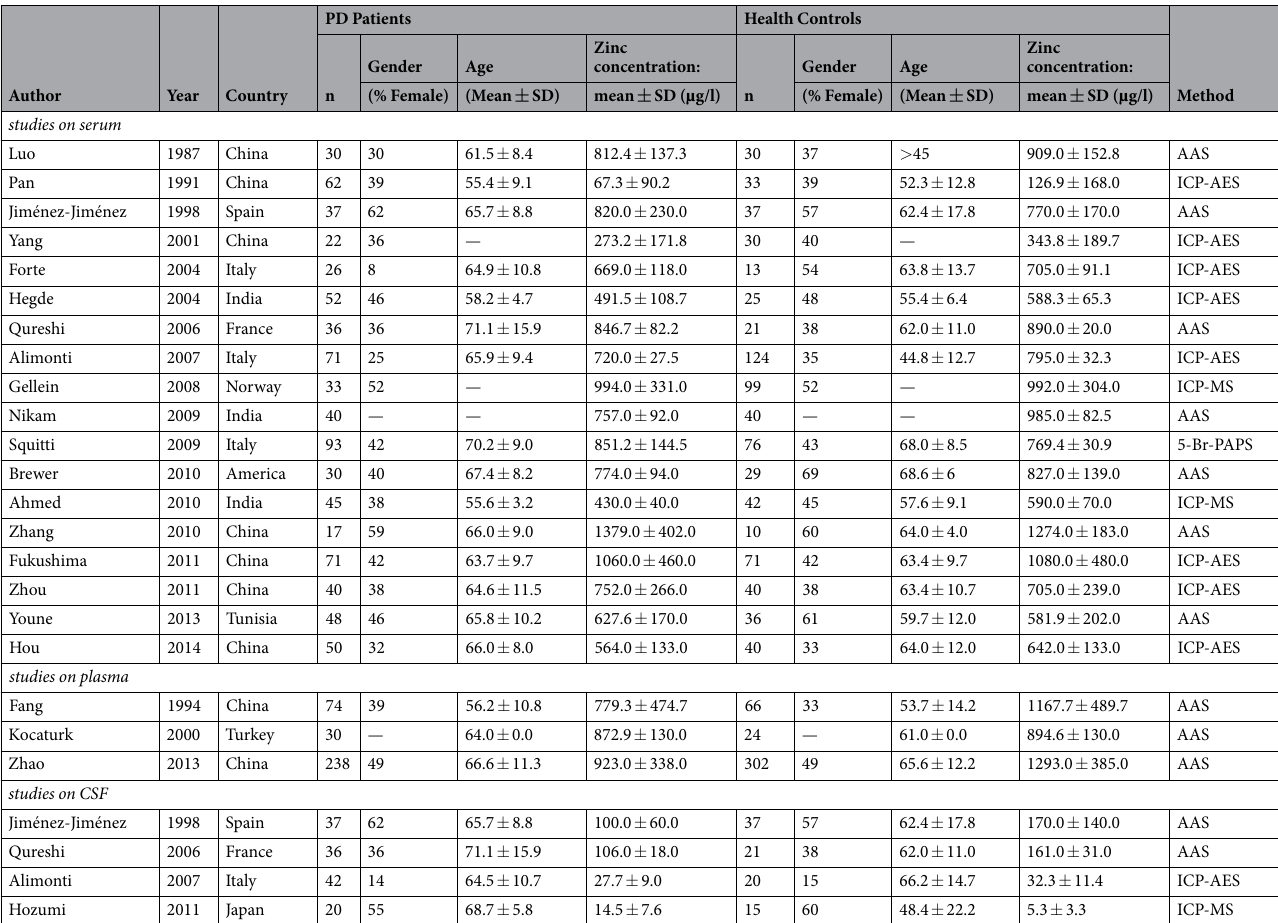
Table 1. Characteristics of studies on the association between Zn levels and PD risk. ICP-MS, inductively coupled plasma-mass spectrometry; ICP-AES, inductively coupled plasma-atomic emission spectrometry; AAS, atomic absorption spectrometry; 5-Br-PAPS, 2-(5-bromo-2-pyridylazo)-5-(N-phenyl-N-sulfopropylamino)